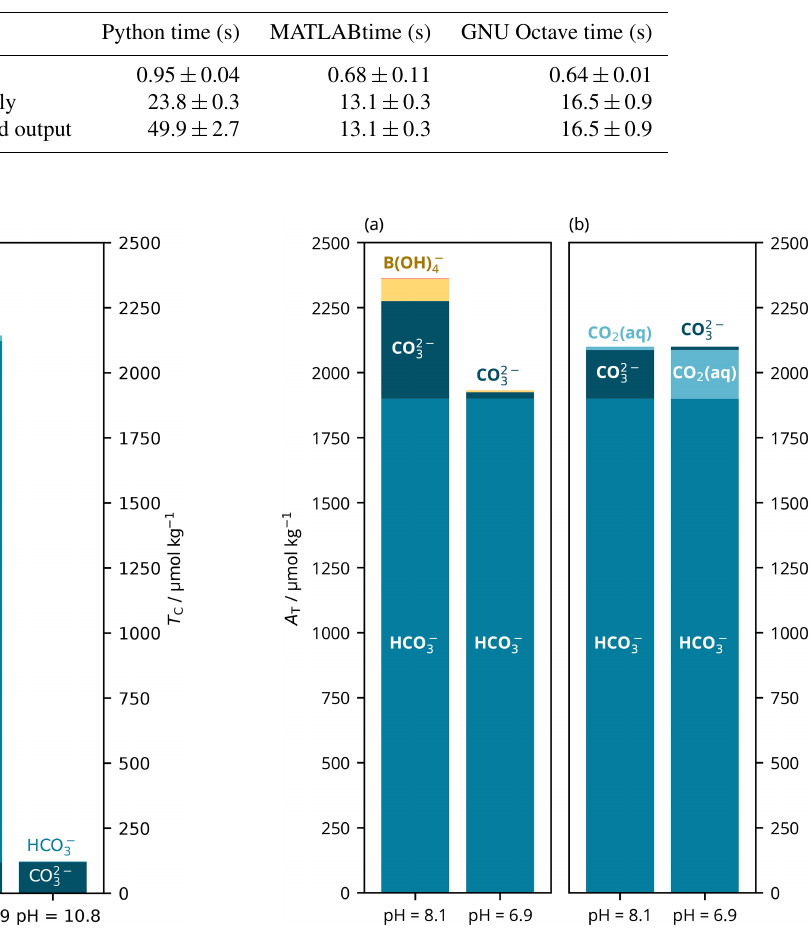
Table 5. Comparison of computational speed for various tasks with PyCO2SYS and CO2SYS-MATLAB running in both MATLAB and GNU Octave. Values shown are the mean ± standard deviation of seven runs. The tasks are described in Sect. 5.4.